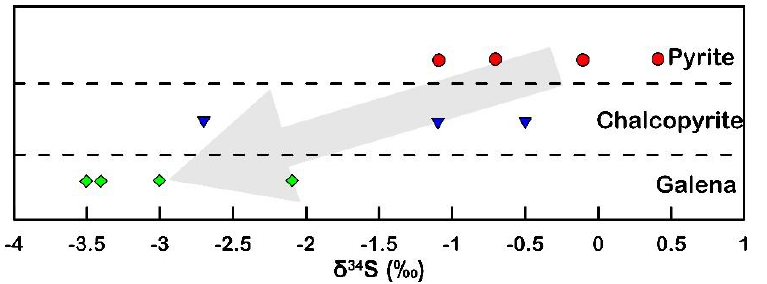
Figure 17. Distribution of the δ 34 S values in the studied sulfide minerals from the Halılar area.